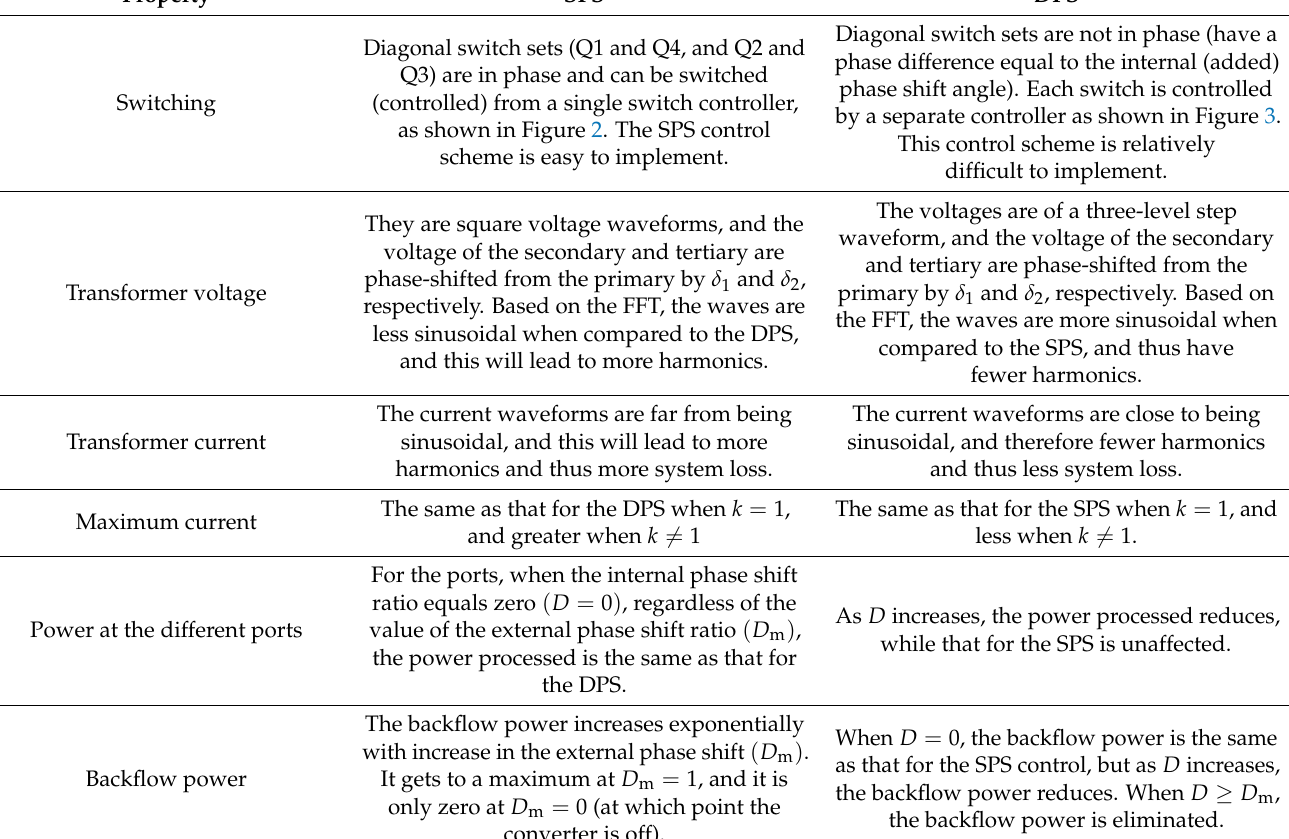
Table 4. Summary of comparison